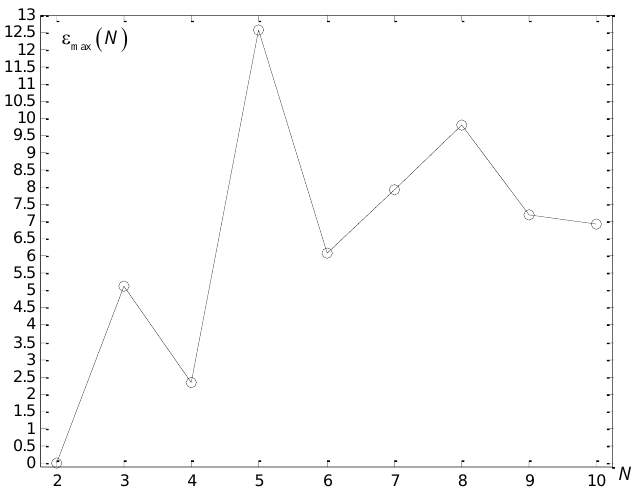
Fig. 6. The common gap maximum taken over 400 instances for each number of jobs. The top peak at 5 jobs is a result of the pseudorandomness artefact viewed and mentioned above (Fig. 1). The gap slowly decreases since 8 jobs.